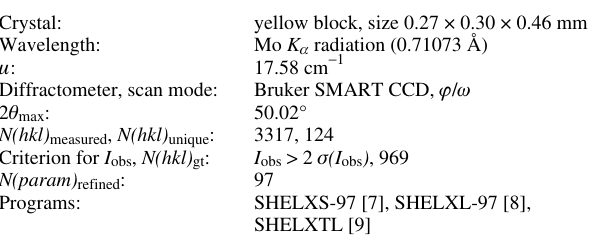
Table 1. Data collection and handling.